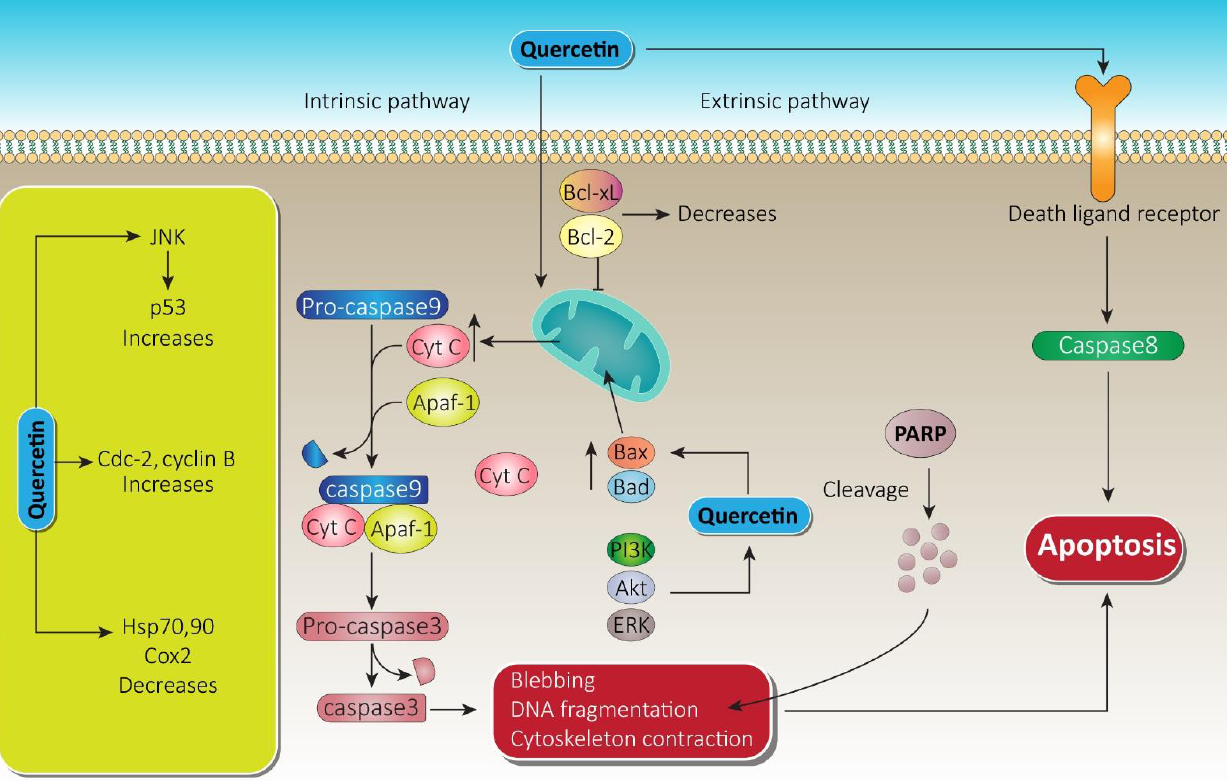
Figure 5. Quercetin apoptotic mechanism via death ligand and mitochondrial membrane. Following the intrinsic pathway, quercetin causes massive release of Cyt-c from the mitochondrial intramembranous space and induces apoptosomes. Furthermore, via blebbing, DNA fragmentation, and cytoskeleton contraction, it paves the way to apoptosis. On the other hand, through the extrinsic pathway, quercetin initiates caspase-8, which leads to apoptosis. A substantial increase in JNK and cdc cyclin B while decreasing heat shock proteins by quercetin also promotes therapy of prostate cancer. Bcl-xL, B-cell lymphoma extra-large; Bcl-2, B-cell lymphoma-2; Cyt-c, cytochrome c; JNK, c-jun N terminal kinase; ERK, extracellular signal regulated kinase; PARP, poly ADP-ribose polymerase; PI3K, phosphoinositide 3 kinase; Akt, serine/threonine specific protein